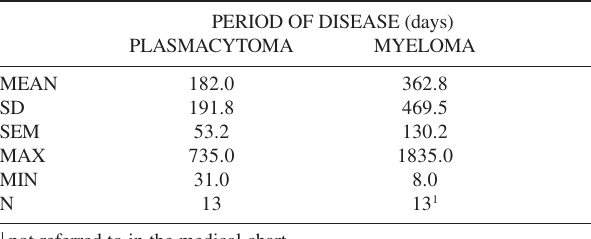
Table 3 - Time (days) from symptom onset until diagnosis in patients with plasmacytoma vs patients with plasmacytoma that progressed to multiple myeloma